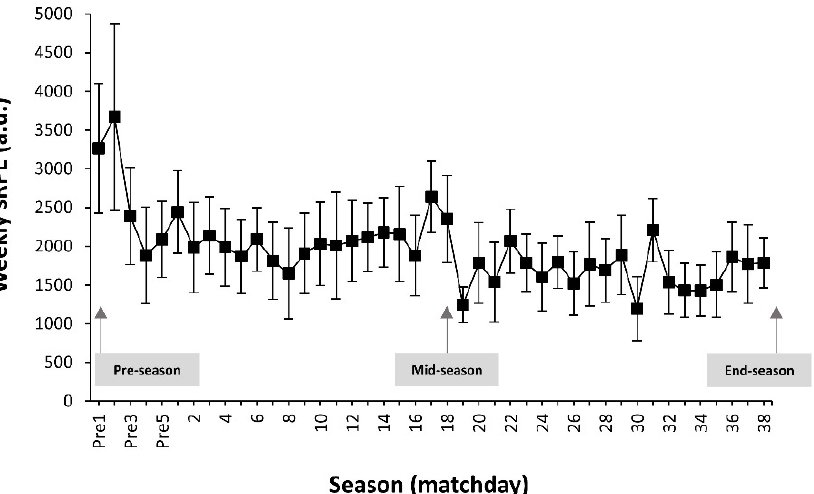
Figure 1. Week-long accumulated values of the session rate of perceived exertion (sRPE) across the season. Pre = indicates weeks without official competitions during the pre-season. The arrows indicate the moment of strength and range of motion